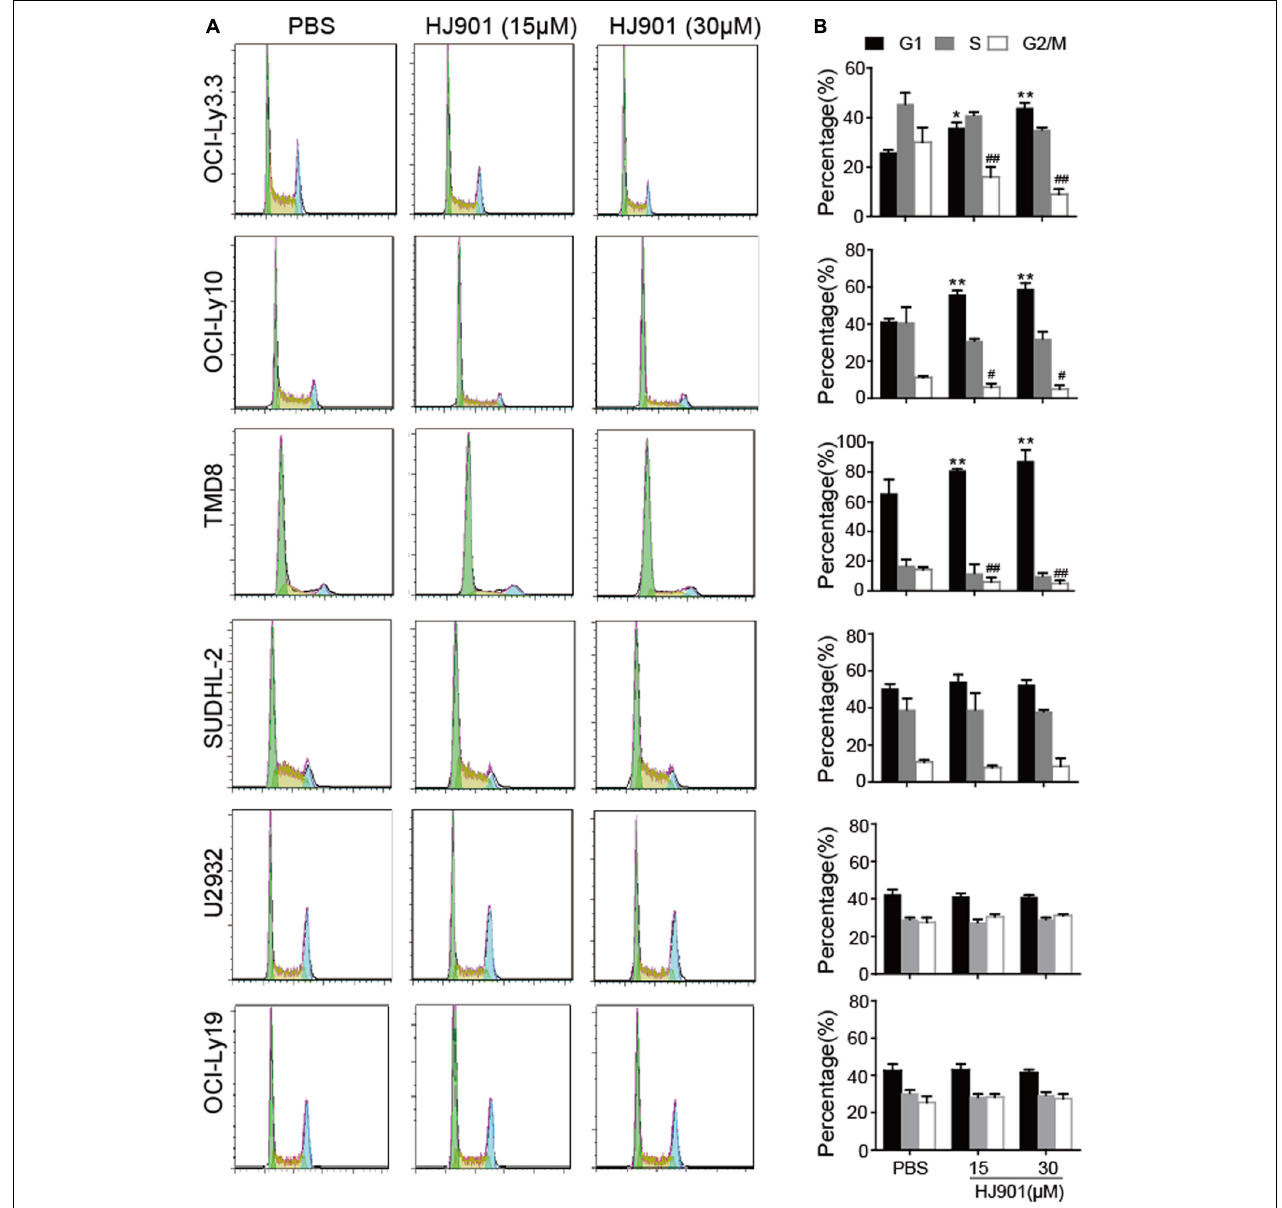
FIGURE 5 | Effect of HJ901 on cell-cycle in DLBCL cell lines. All cells were incubated with or without HJ901 (15 or 30 µ M) for 72 h. (A,B) The cell cycle was analyzed by propidium iodide staining and flow cytometry. Similar results were obtained from three independent experiments. All data are presented as the means ± SEM ( n = 5 in each group). * p < 0.05 and ** p < 0.01 vs. PBS group (G0/G1 phase); # p < 0.05 and ## p < 0.01 vs. PBS group (S